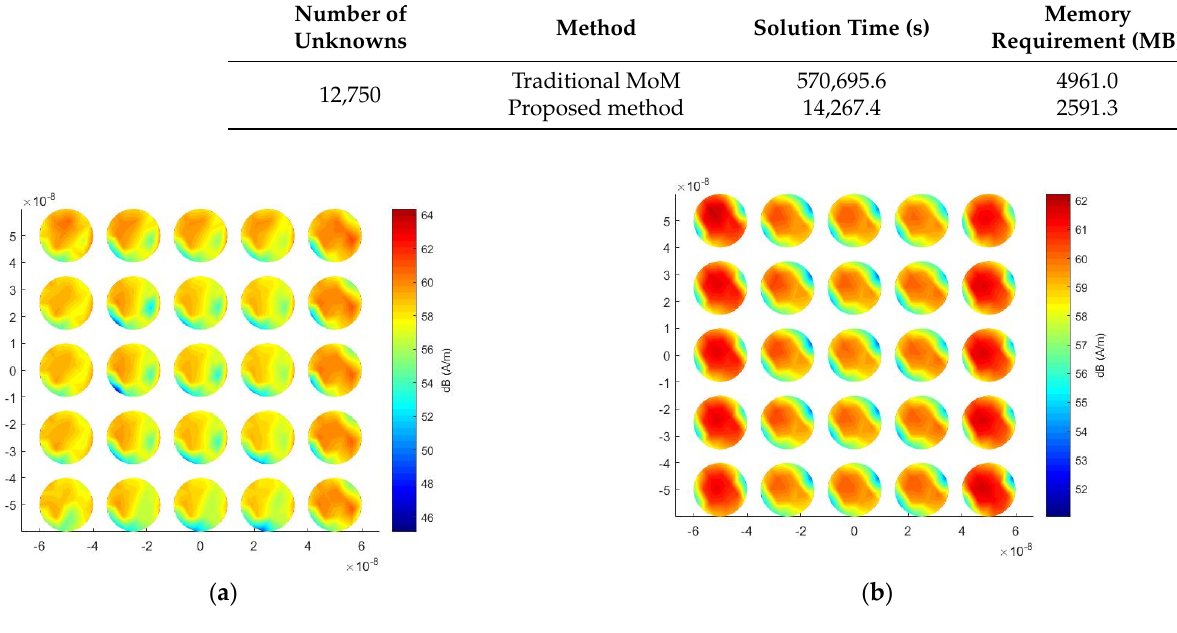
Figure 11. Surface current distribution under different incident angles at 350 nm wavelength for the nanocylinder array. ( a ) 120° incident angle; ( b ) 180° incident angle.